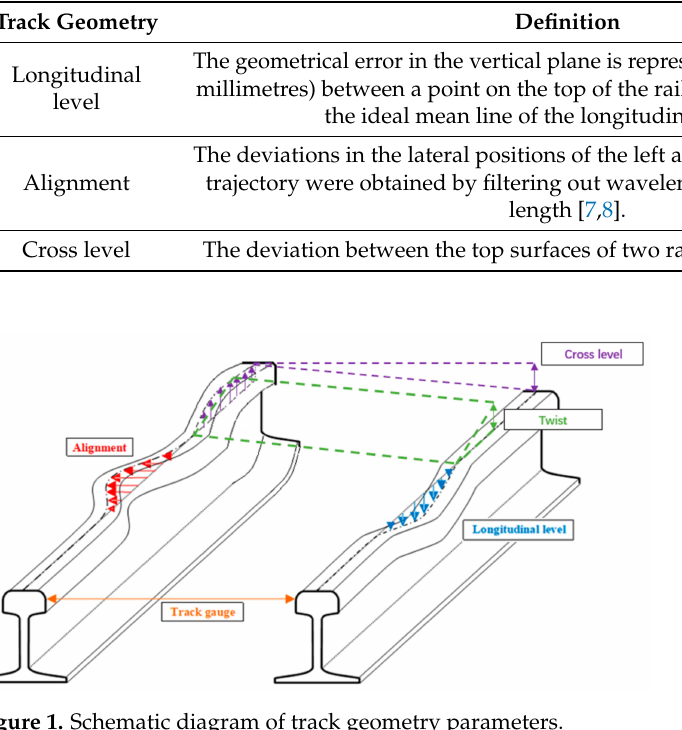
Figure 1. Schematic diagram of track geometry parameters.